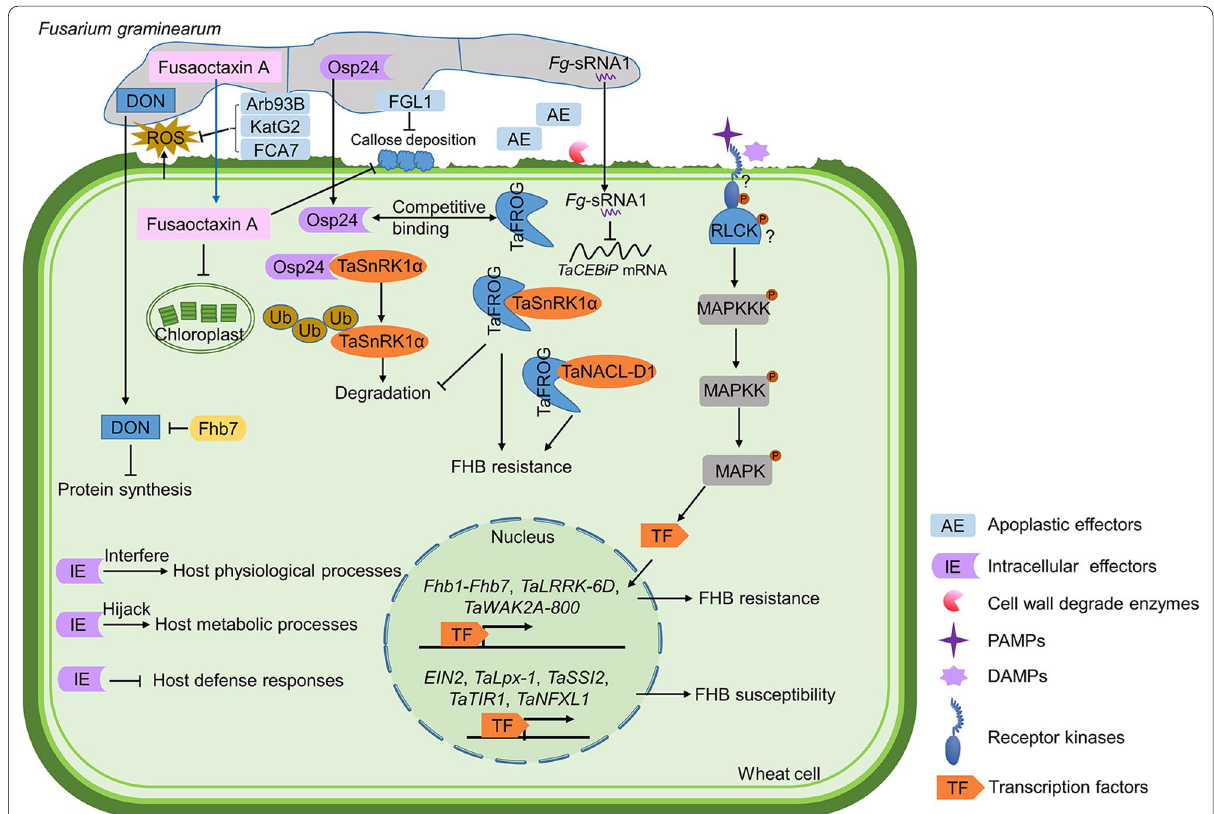
Fig. 2 Mode of action of Fusarium graminearum -secreted pathogenicity factors and FHB resistance and susceptibility genes in wheat during F . graminearum -wheat interaction. F . graminearum secretes cell wall-degrading enzymes (CWDEs) such as polygalacturonases and xylanases to degrade wheat cell walls. The apoplastic effector (AE) FGL1 suppresses callose deposition. F. graminearum exo-1,5-a-L-arabinanase Arb93B and the putative catalase-peroxidase KatG2 and FCA7 contribute to fungal virulence by suppressing host ROS generation. The orphan secreted protein Osp24 in F . graminearum functions as a cytoplasmic effector targeting host defense-related TaSnRK1α for degradation and is important for pathogenicity. The sRNA effector Fg -sRNA1 contributes to virulence by silencing wheat defense-related TaCEBiP . Fungal toxin DON inhibits protein biosynthesis by binding to the ribosome. DON also affects programmed cell death (PCD) of plant cells in a concentration-dependent manner. The fungal toxin Fusaoctaxin A changes the subcellular localization of chloroplasts in the coleoptile cells and prevents callose accumulation in plasmodesmata during pathogen infection, facilitating the cell-to-cell invasion of F. graminearum in wheat tissues. To combat F. graminearum , the DON response wheat orphan and defense-related protein TaFROG competes with Osp24 to interact with TaSnRK1α, preventing TaSnRK1α degradation mediated by the ubiquitin-26S proteasome system. TaFROG also interacts with the FHB resistance-related NAC-like transcription factor TaNACL-D1. Wheat FHB resistance genes Fhb1 – Fhb7 and pattern-triggered immunity (PTI) components, such as TaLRRK-6D and TaWAK2A-800 , confer resistance to FHB. Fhb7 encodes a glutathione S -transferase which detoxifies multiple trichothecene mycotoxins, whereas the wheat ethylene receptor gene EIN2 , the 9-lipoxygenase-coding gene TaLpx-1 , the stearoyl-acyl carrier protein fatty acid desaturase gene TaSSI2 , the auxin receptor gene TaTIR1 , and the DON-induced transcription factor gene TaNFXL1 contribute to wheat susceptibility to